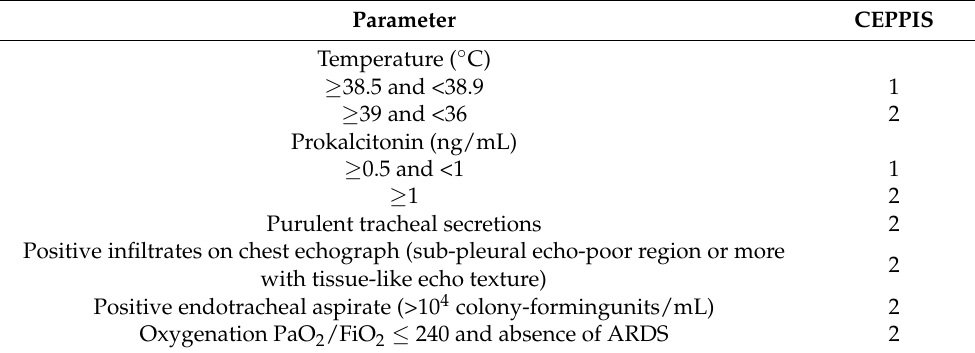
Table 1. Chest Echocardiography and Procalcitonin Pulmonary Infection Score (CEPPIS) used in the diagnosis of VAP in the prospective and retrospective cohort (CEPPIS > 5 = VAP). Parameter CEPPIS Temperature ( ◦ C) ≥ 38.5 and <38.9 1 ≥ 39 and <36 2 Prokalcitonin (ng/mL) ≥ 0.5 and <1 1 ≥ 1 2 Purulent tracheal secretions